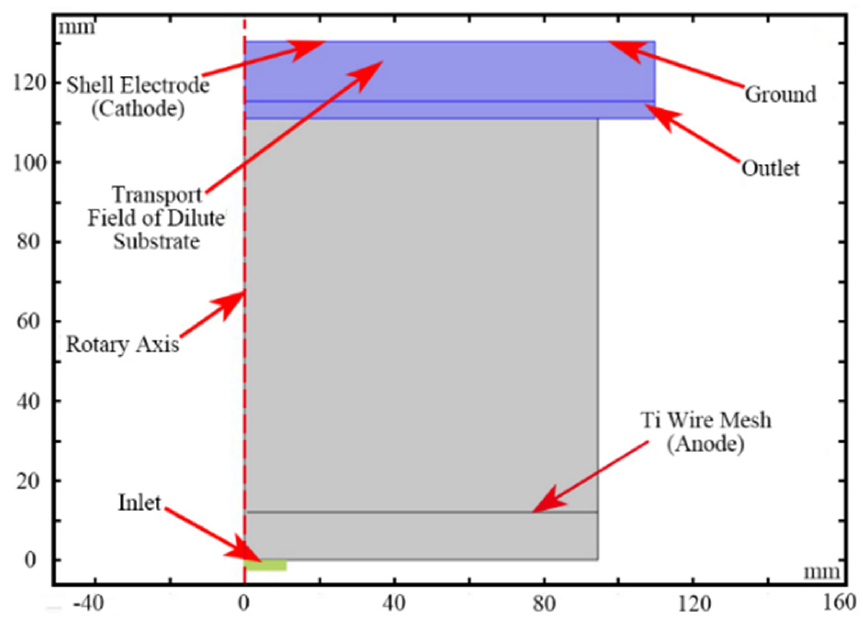
Figure 2. 2D rotation cross-section of flow field simulation model.